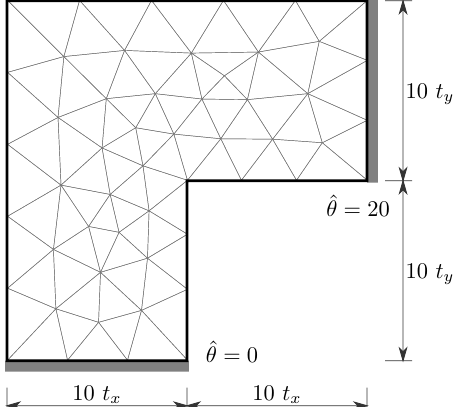
Figure 3. A scheme of the problem definition. The edge lengths t x and t y of the tiles were set as t x = t y = 6. All quantities are in consistent units.